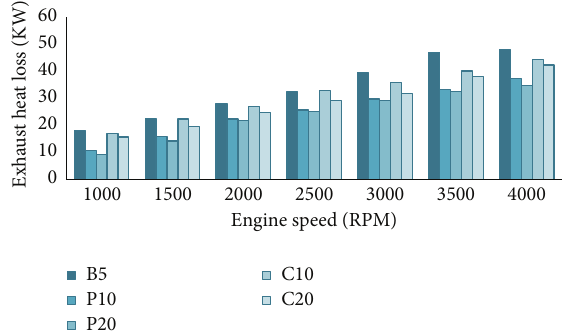
Figure 11: Lubricating oil heat loss ( 𝑄 load.